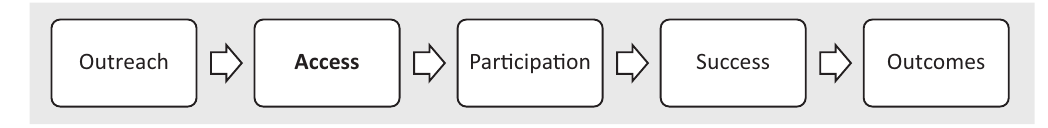
Figure 1. Constitutive stages of social inclusion in higher